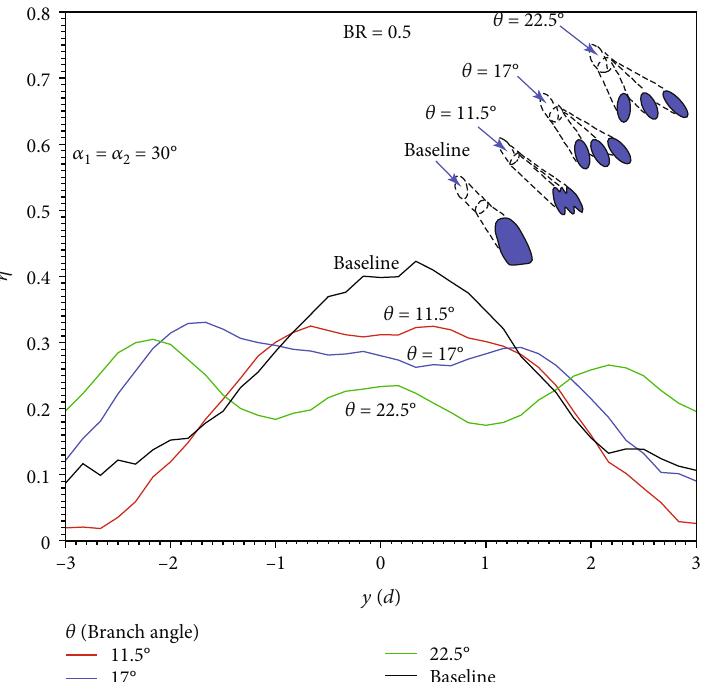
Figure 21: Spanwise (streamwise-averaged) fi lm e ff ectiveness variations at x/d=5 for α ratio of